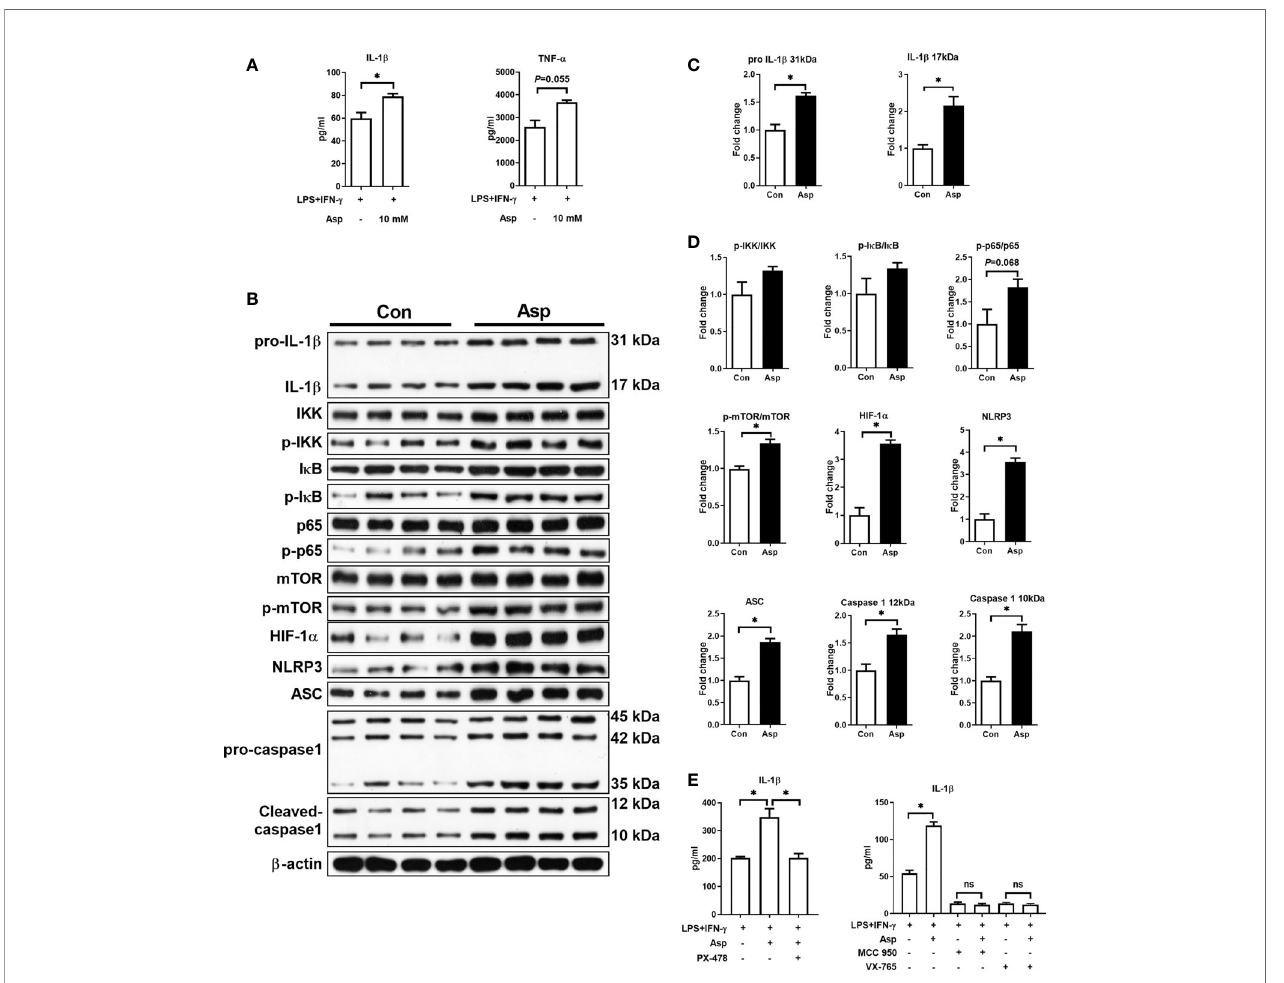
FIGURE 2 | Aspartate promotes the production of interleukin 1 b (IL-1 b ) and the activation of signal pathways in macrophages. (A) IL-1 b and tumor necrosis factor alpha (TNF- a ) secretion in macrophages ( n = 5). (B – D) Protein abundance of IL-1 b , I k B kinase (IKK), p-IKK, I k B, p-I k B, p65, p-65, mammalian target of rapamycin (mTOR), p-mTOR, S6K1, p-S6K1, hypoxia-inducible factor-1 a (HIF-1 a ), Nod-like receptor protein 3 (NLRP3), apoptosis-associated speck like protein containing a caspase recruitment domin (ASC), and caspase-1 in macrophages ( n = 4). (E) IL-1 b secretion in M1 macrophages ( n = 3 – 4). Data were analyzed with unpaired t -test (A – D) or with one-way ANOVA (E) . Error bars represent the mean ± SEM. ns, not signi fi cant. * p ≤